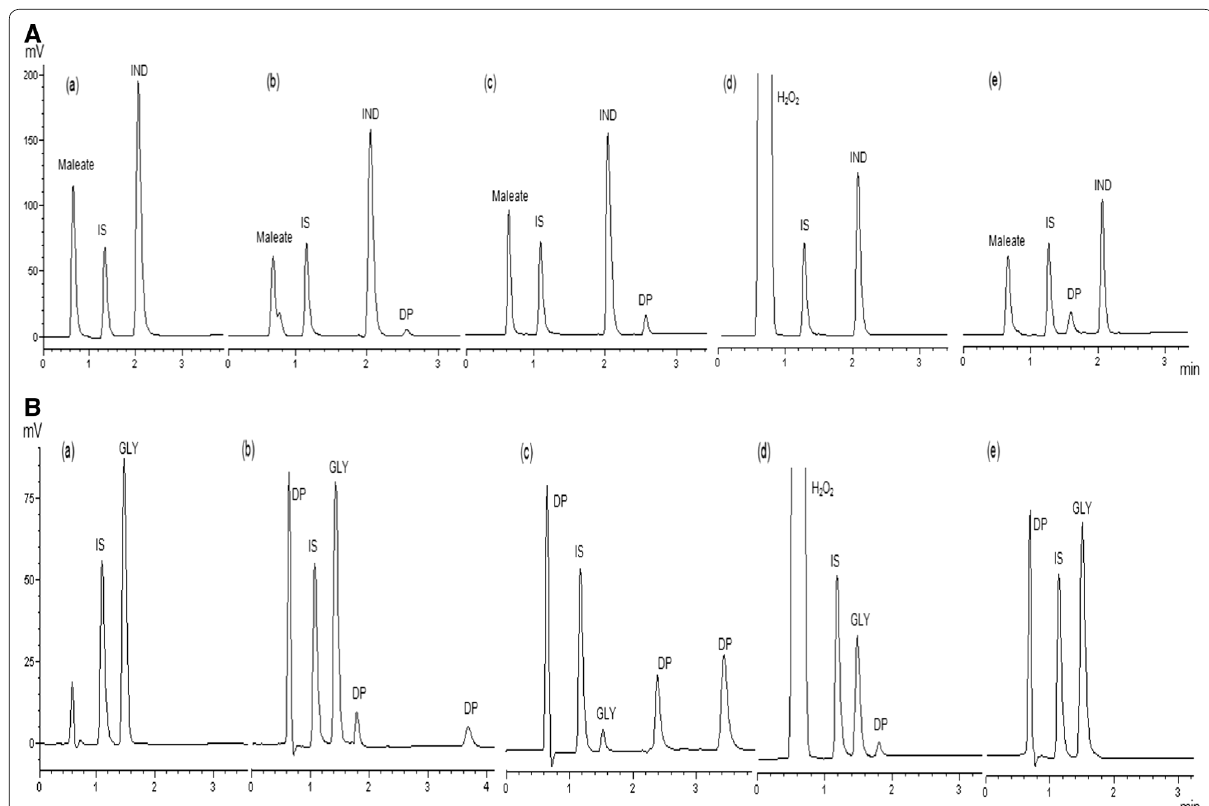
Fig. 3 HPLC chromatograms of A indacaterol maleate (IND; 20 μg/mL) and B glycopyrronium bromide (GLY; 20 μg/mL) after ( a ) neutral hydrolysis ( b ) acidic hydrolysis; ( c ) alkaline hydrolysis; ( d ) oxidation and ( e ) exposition to UV light. IS internal standard (15 µg/mL), DP degraded